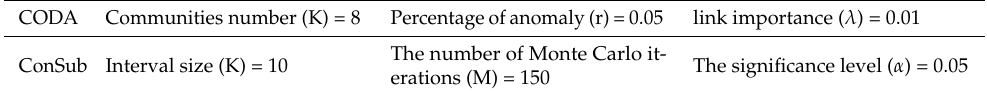
Table 1. Models Parameter